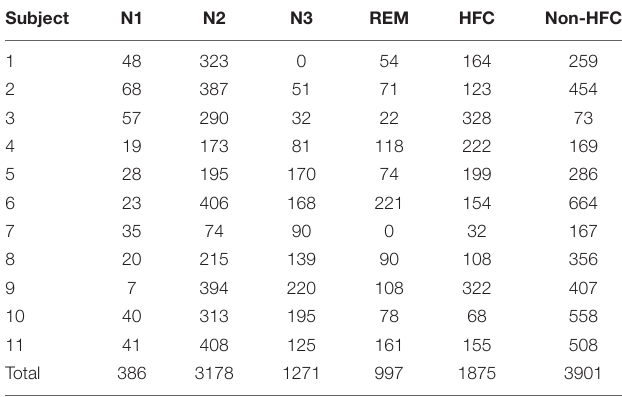
TABLE 2 | (Data -2): Epochs of artifact free conventional stage/interpolated CPC.